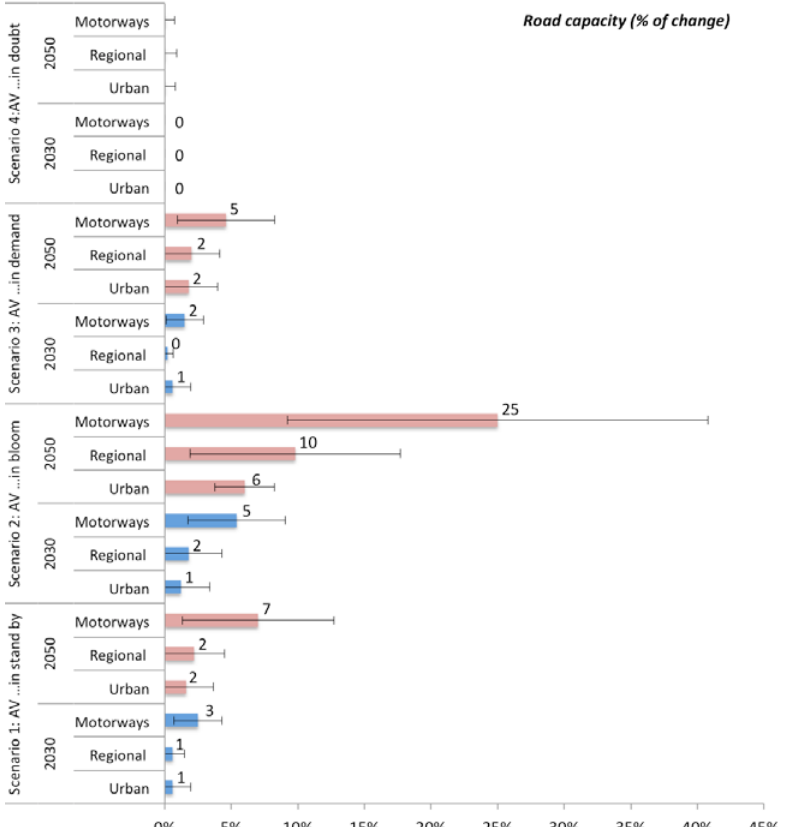
Figure 5. Estimation of capacity changes in different scenarios. Each bar represents average value of five experts responses collected in Delft University of Technology workshops and error bar depicts standard deviation.